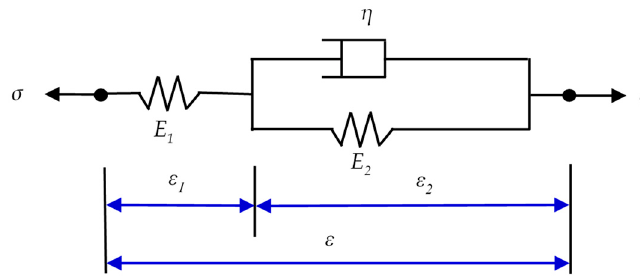
Figure 5. The mechanical model of the improved